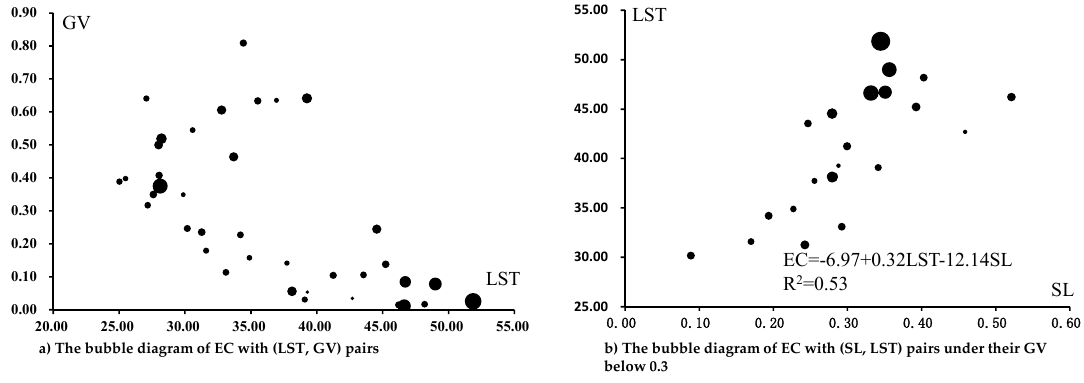
Figure 7. The bubble diagram of EC with the related EMs and LST. ( a ) The bubble diagram of EC with (LST, GV) pairs; ( b ) The bubble diagram of EC with (SL, LST) pairs under their GV below